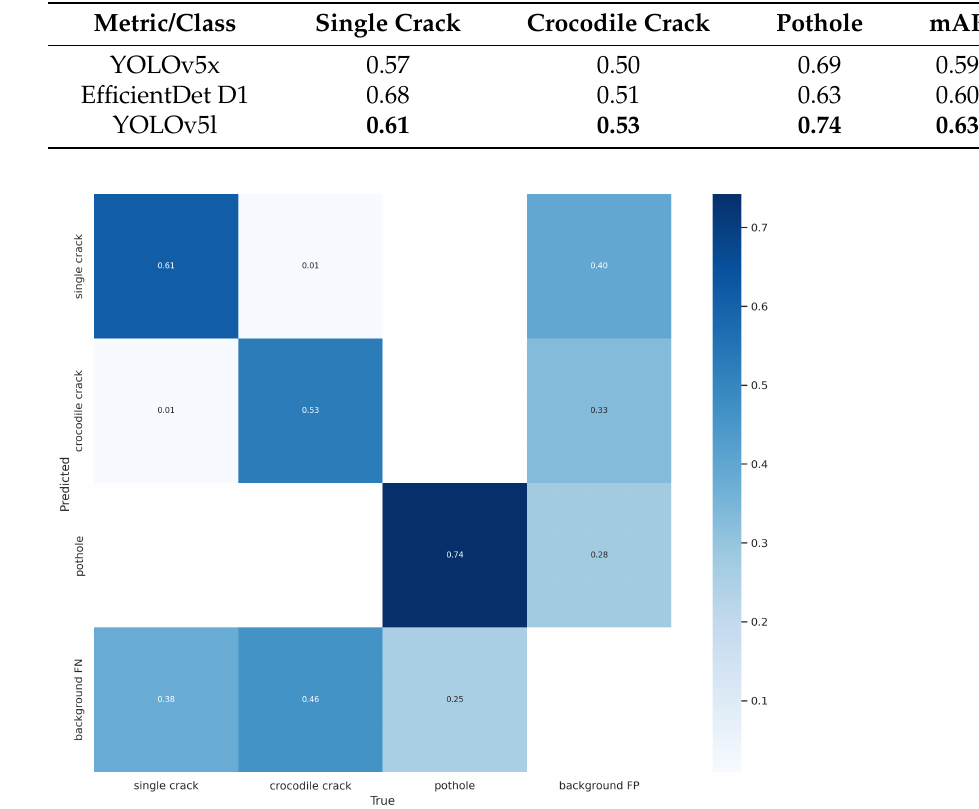
Table 7. Average precision comparison between the YOLOv5 and EfficientDet object detectors.